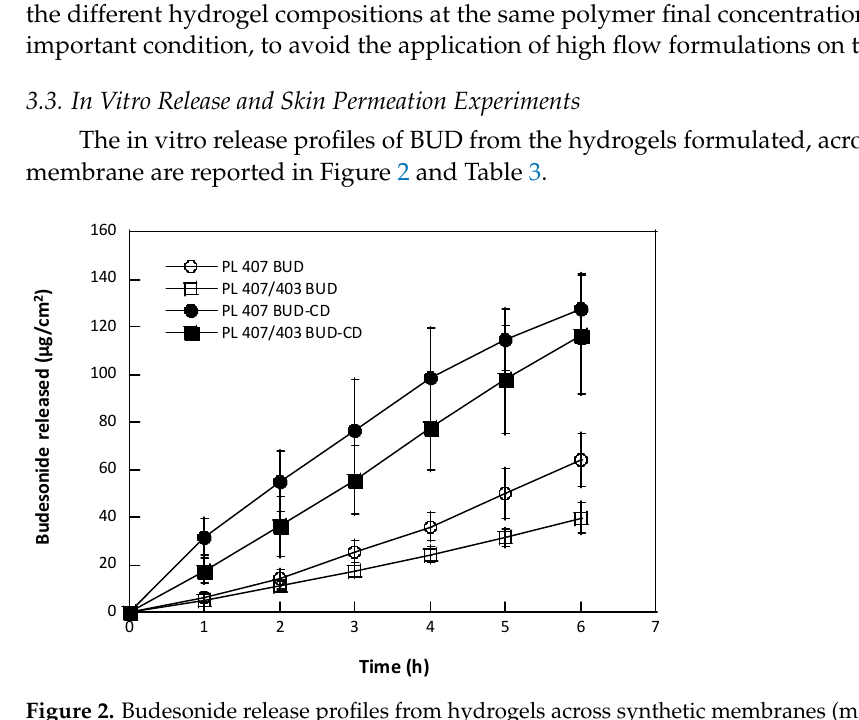
Figure 2. Budesonide release profiles from hydrogels across synthetic membranes (mean value ± sd, n = 6/formulation). Table 3. Budesonide release constants from PL-based hydrogels, according to mathematic models.